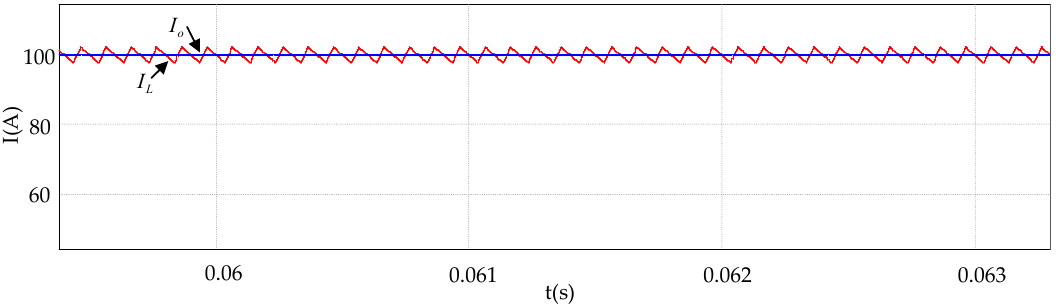
Figure 14. Waveforms of the inductance current in steady-state.